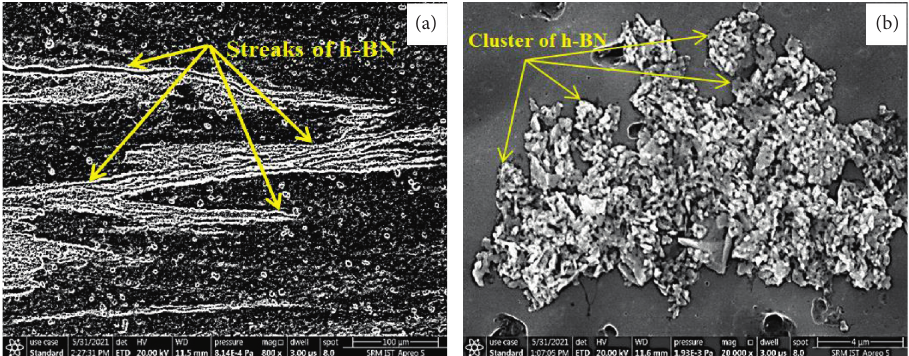
Figure 12: FESEM graphs of (a) nugget center and (b) FSW bottom